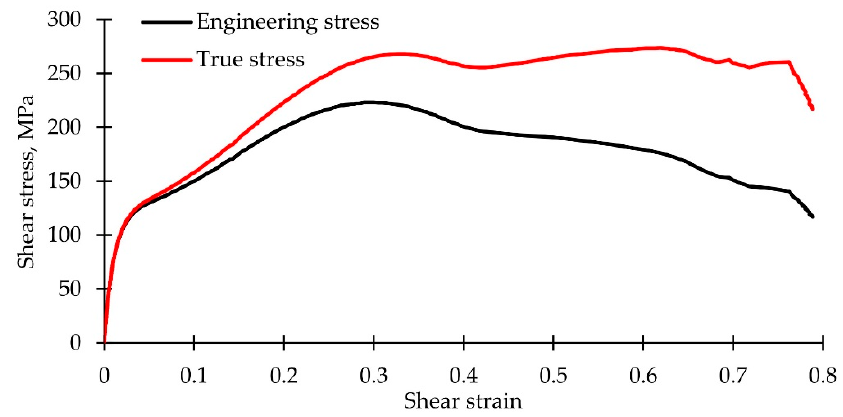
Figure 4. Stress–strain curves constructed with the use of engineering and true stresses. Polymers 2022 , 14 , 4502